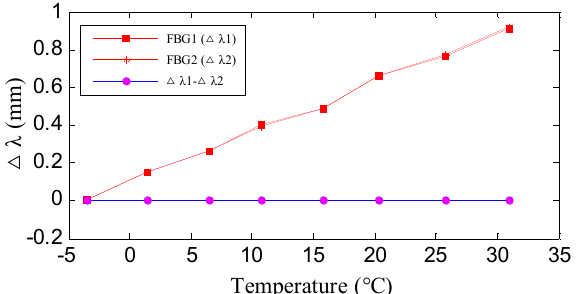
Figure 3. Temperature self-compensation of the FBG bending gauge.